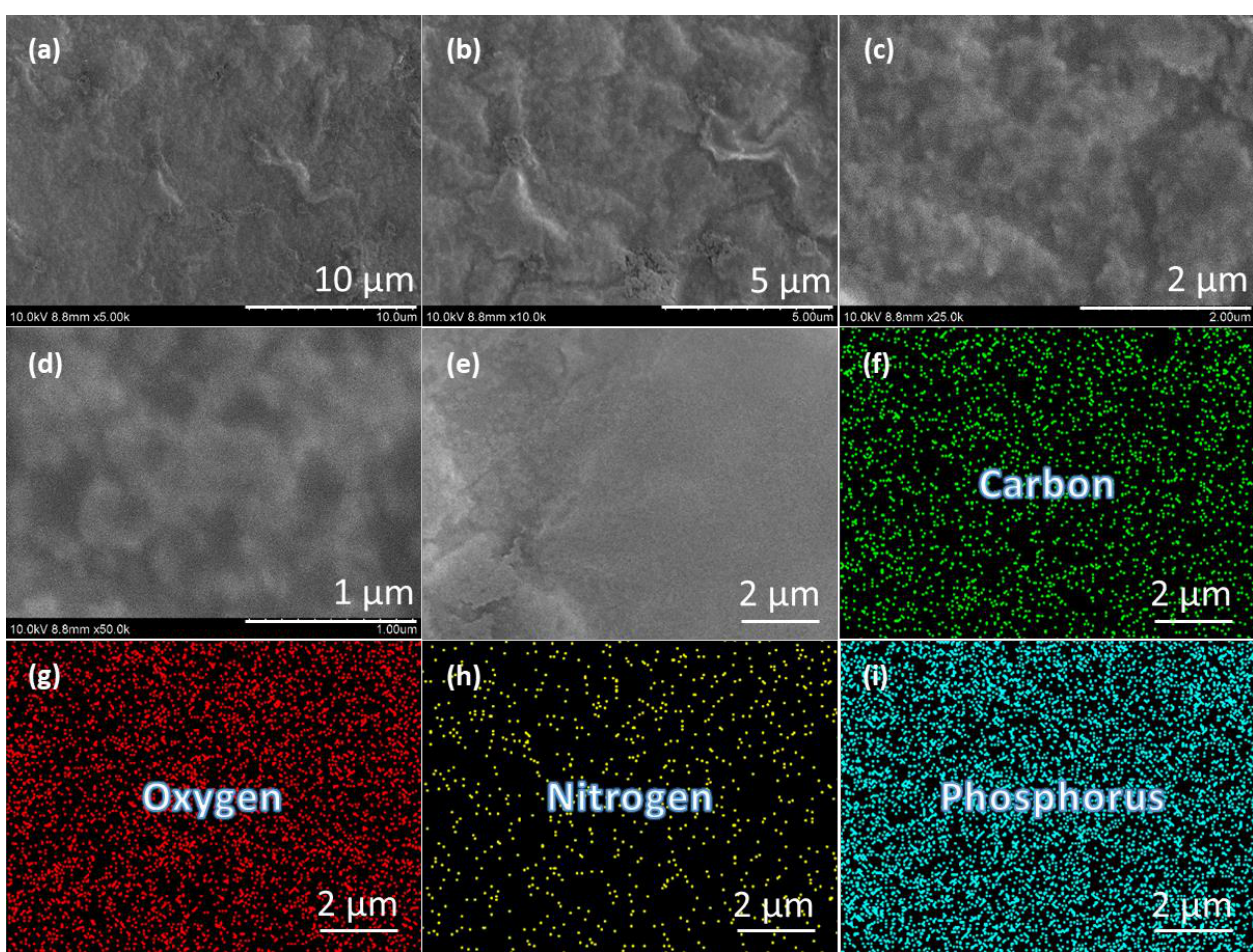
Figure 1. ( a – d ) FESEM images with different magnifications of P-CDs synthesized from PMPC; ( e ) FESEM electron image and the corresponding EDX mapping of ( f ) carbon, ( g ) oxygen, ( h ) nitrogen and ( i ) phosphorus elements of synthesized P-CDs.